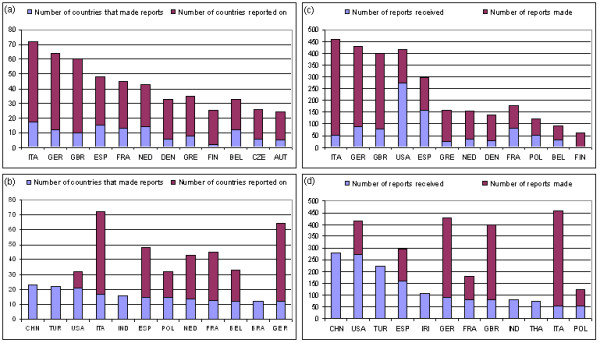
Total trends in reporting for the top 12 countries with blue = 'transgressor' and red = 'detector': a) Sorted by country making the highest number of reports against other countries; b) Sorted by number of other countries making reports against the selected country; c) Sorted by total number of reports made by against all products; d) Sorted by total number of reports against products from the selected country.